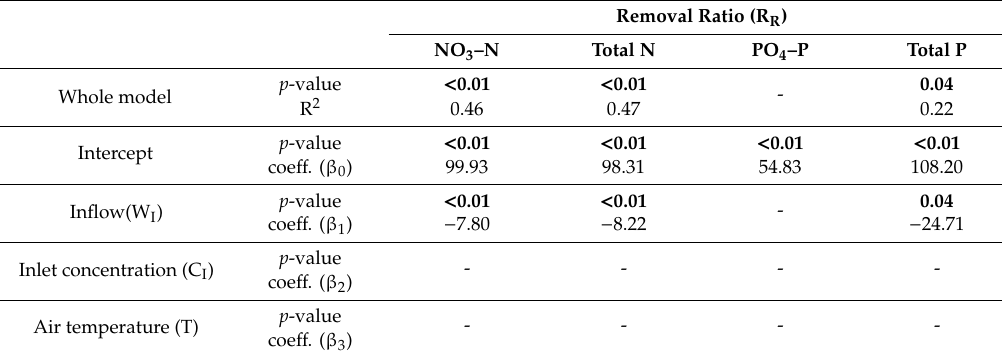
Table 6. Parameters of the selected models per each nutrient form. Whole model parameters ( p -value and R squared) and predictors parameters ( p -values and regression coe ffi cients) are reported. p -values < 0.05 are in bold. Expressions in parentheses refer to Equation (4). Removal ratio (monthly values) is in %; inflow (monthly volumes) in 10 3 mm, inlet concentration (monthly flow-weighted) in 10 3 mm, air temperature (monthly average) in ◦